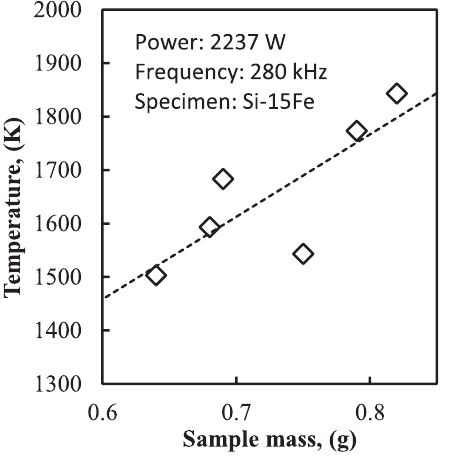
Fig. 11: Effect of specimen mass on droplet